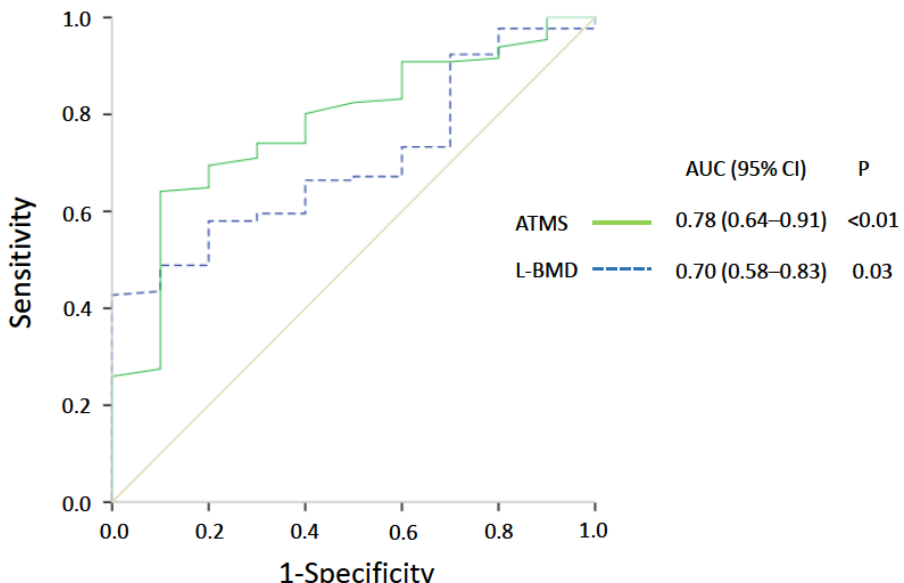
Figure 2. Receiver operating characteristic curves. The analysis revealed that the best cutoff points for ATMS and L-BMD were 4.0 kPa with an AUC of 0.78 and 1.11 g/cm 2 with an AUC of 0.70, respectively. Abbreviations: AUC, area under the curve; ATMS, abdominal trunk muscle strength; CI, confidence interval; L-BMD, bone mineral density of the lumbar spine.